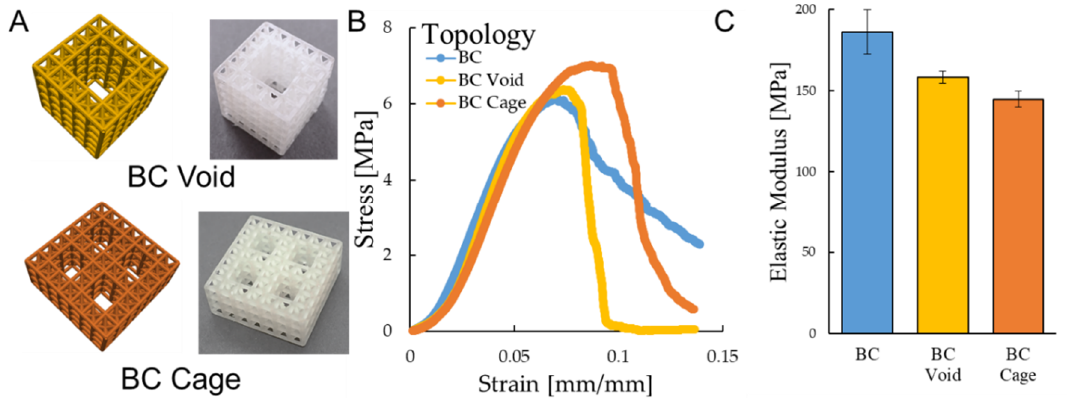
Figure 8. CAD designs and fabrications for ( A ) BC-Void and BC-Cage designs with ( B ) stress–strain curves, and ( C ) elastic moduli measurements when compared to BC 5 × 5 × 5